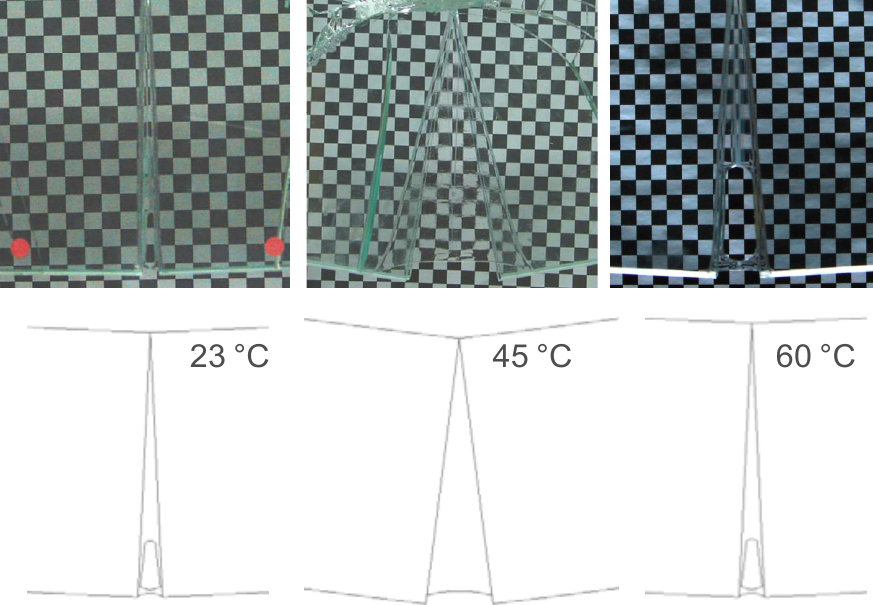
Figure 4: Typical deformation/tearing patterns at the different temperatures (series 150